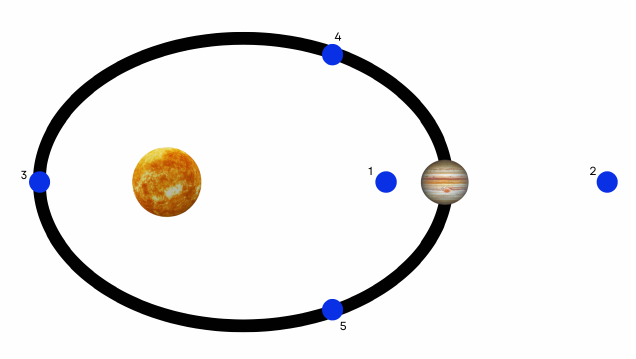
Figure 2. Nodes in Lagrangian